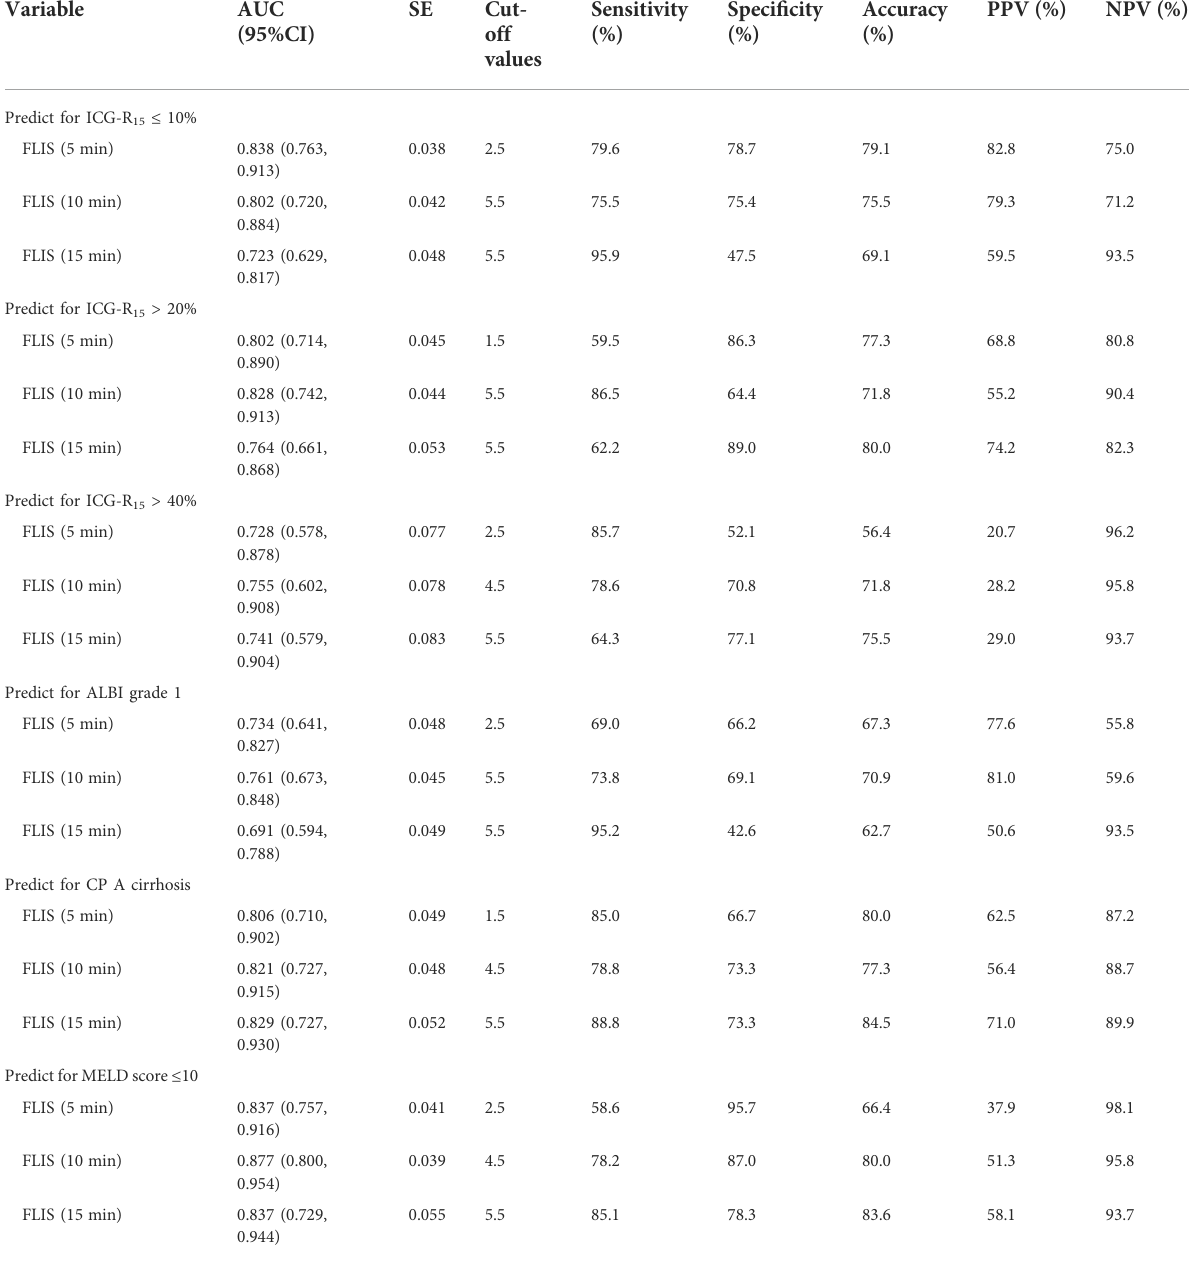
TABLE 7 Diagnostic performance of FLIS at different time points for the prediction of ICG-R 15 , ALBI grade, CP class and MELD score. AUC, area under curve; CI, con fi dence interval; SE, standard error; PPV, positive predictive value; NPV, negative predictive value. Variable AUC SE Cut- (95%CI)